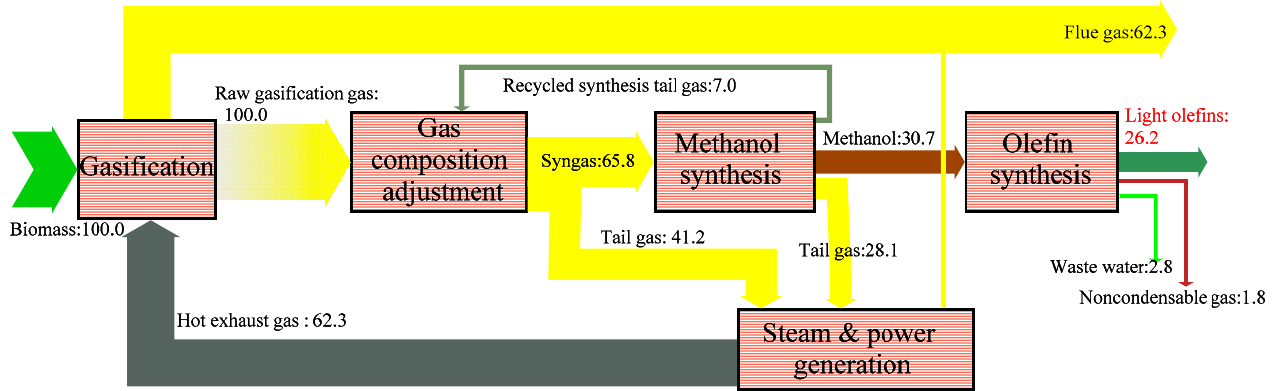
Figure 8. Schematic layout of system d carbon flow. (%, based on biomass exergy).